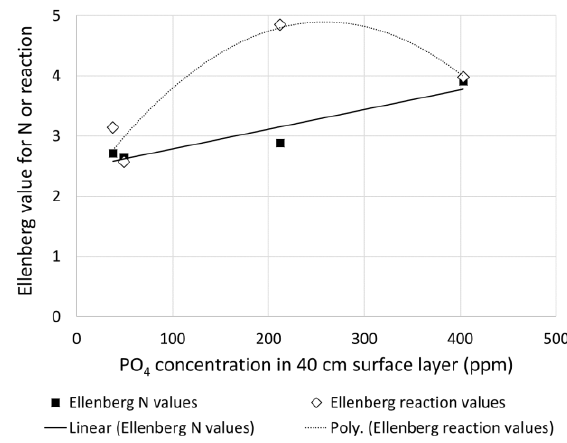
Figure 3. Ellenberg indicator values for N and reaction (y-axis) in relation to measured PO concentrations (x-axis) in a 40 cm layer of surface peat and sediment. Trend lines are shown but the correlations are not statistically significant due to the small number of